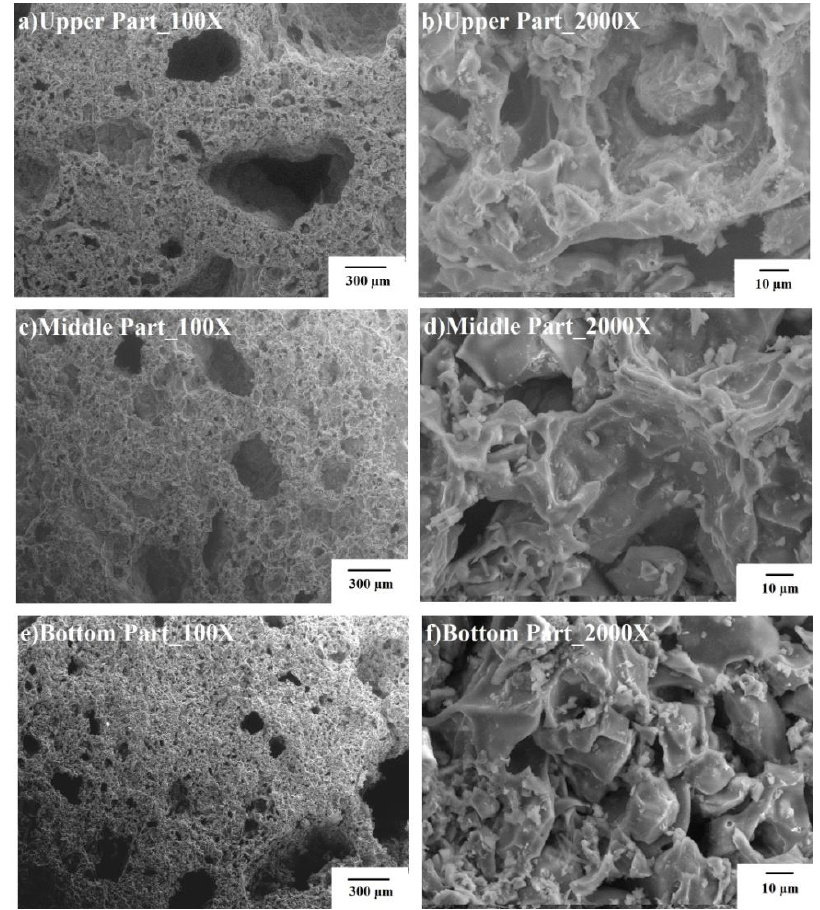
Figure 3. SEM images for TGPFs.